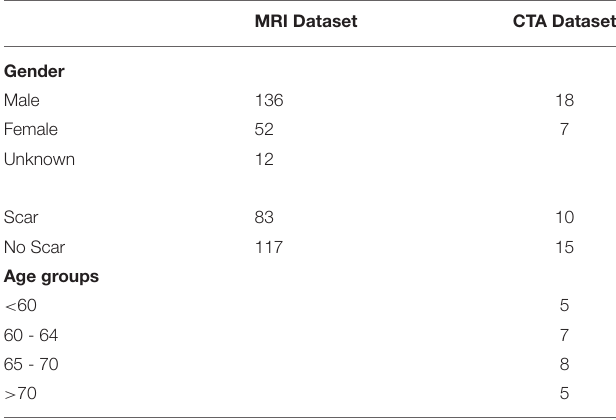
TABLE 1 | Demographic information for both magnetic resonance imaging (MRI) training dataset and the computed tomography angiography (CTA) testing